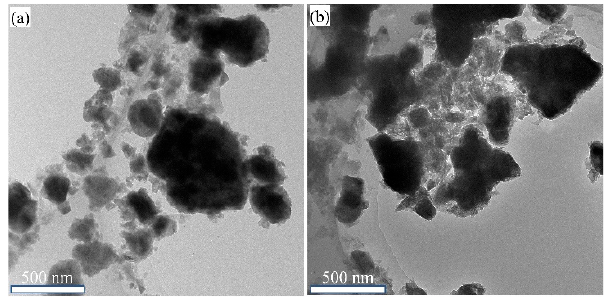
Figure 2. TEM images of ( a ) Sr 2 TiO 4 ; ( b ) Sr 2 TiO 4 :N,Nb(2%). TEM elemental mapping of Sr 2 TiO 4 was performed and the results were shown in Figure 3a–d. It verified the existence of Sr, Ti, O, and these elements were distributed evenly. TEM elemental mapping of Sr 2 TiO 4 :N,Nb(2%) was also performed and the results